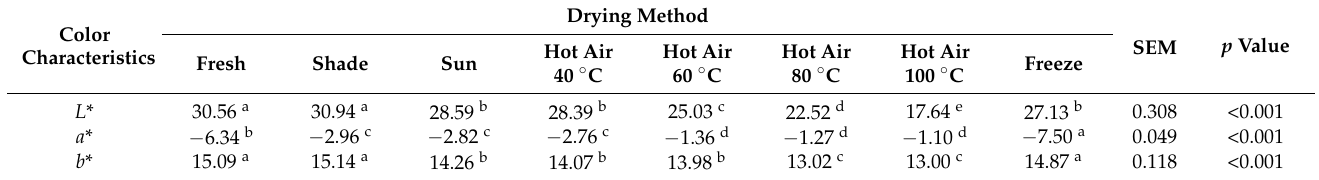
Table 5. Effect of different drying methods on the color characteristics of Piper sarmentosum Roxb. leaves. Color